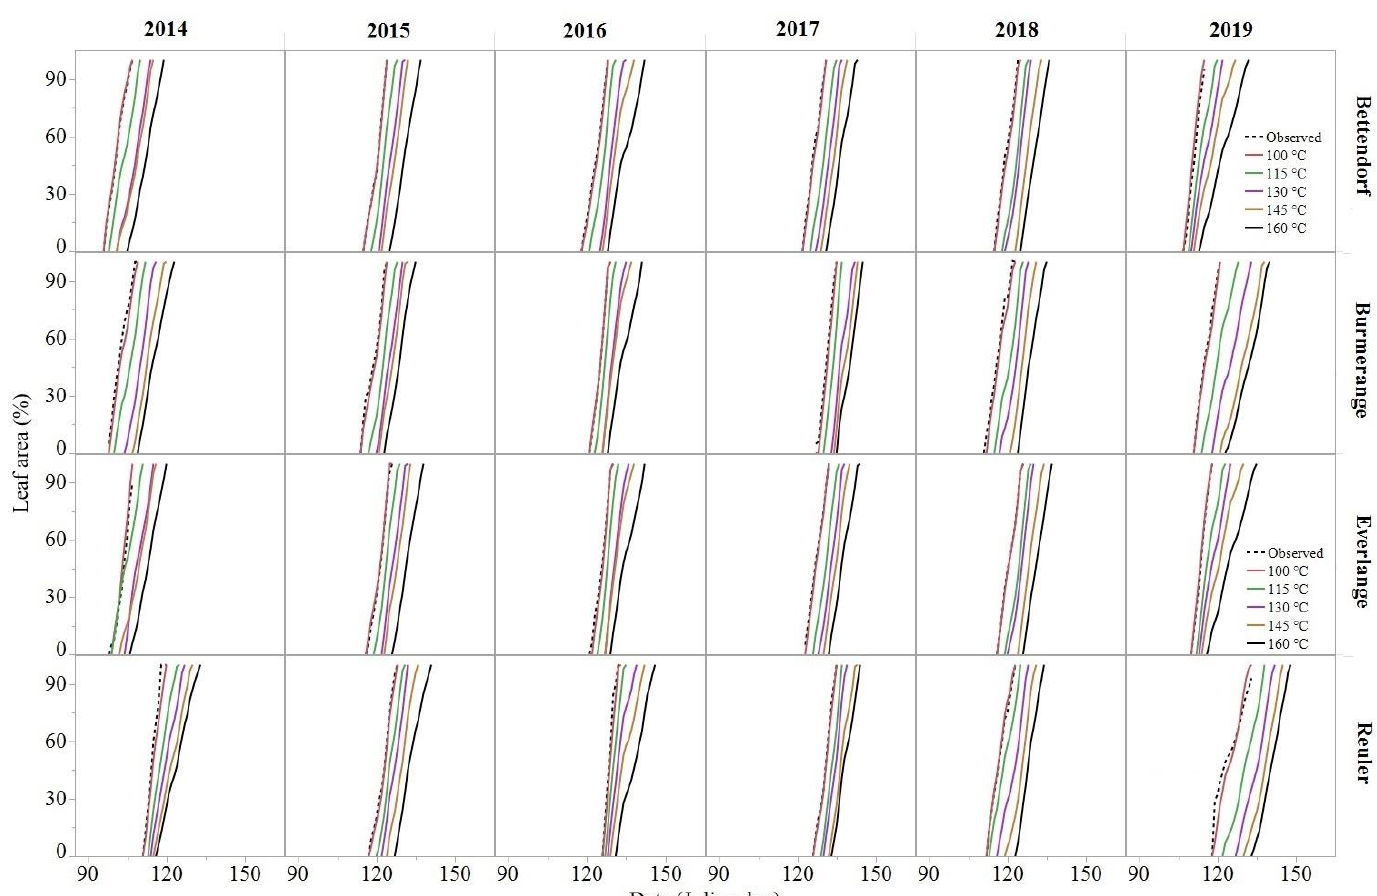
Figure 8. Observed (dashed lines) and predicted (solid lines) percentage emergence (in this case measure as first visible appearance) of the flag leaf (F) in winter barley during the 2014–2019 cropping seasons in the Grand-Duchy of Luxembourg. The percentage of emerged leaf area for each of the three leaf layers was estimated by comparison to the total area of the preceding fully emerged leaf (assumed as 100%), and by checking the ligule of the emerging leaf (a fully visible leaf ligule corresponds to a fully emerged leaf). The percentage emerged areas were estimated for each of the 40 replicate plants at each assessment. Note: the curves for observed values and predicted values using the 100 °Cd phyllotherm are superposed in most of the graphs.